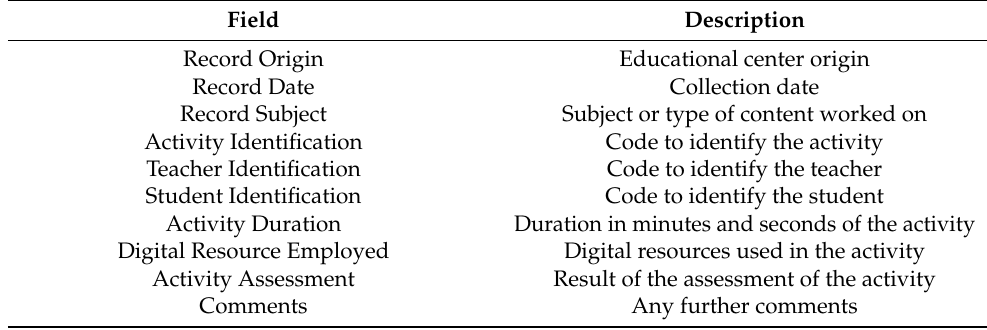
Table 1. Main fields to be collected for each activity.